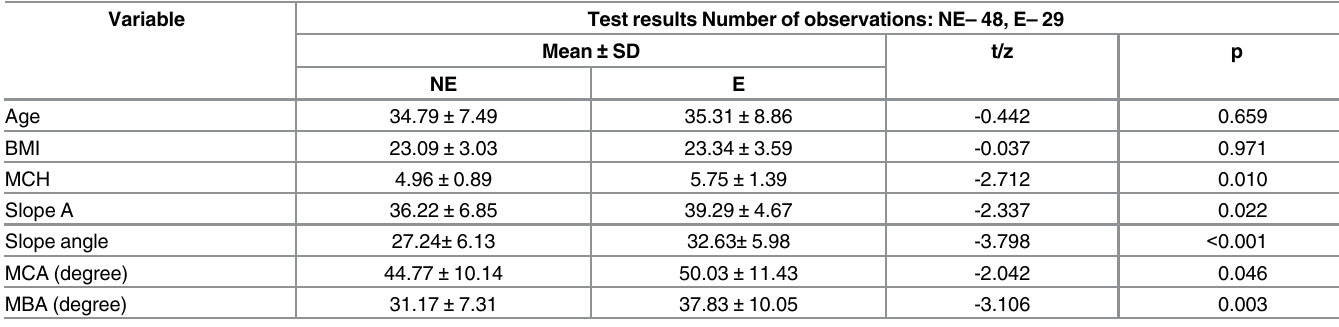
Table 1. Test results for difference between the groups NE and E.